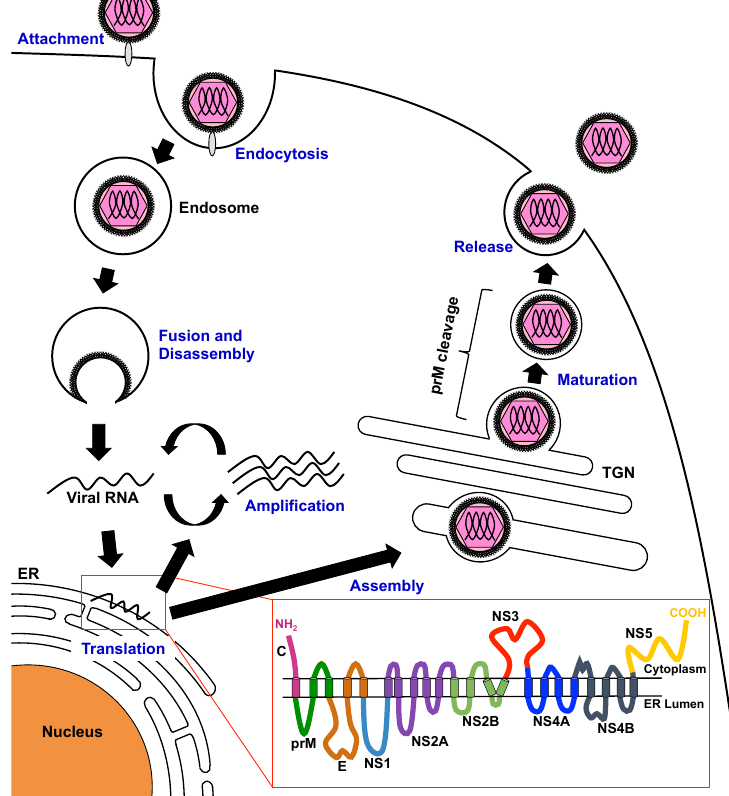
Figure 1. Schematic model of the dengue virus (DENV) life cycle. DENV particles bind to host cell factors and then enter the cell by clathrin-mediated endocytosis. After trafficking to endosomal compartments, envelope protein-mediated fusion of viral and cellular membranes occurs with changes in pH, allowing disassembly of the virus particles and release of single-stranded viral RNA into the cytoplasm, where translation occurs. The viral RNA is then translated to a polyprotein, which is processed by host cellular and viral proteases. Nonstructural (NS) proteins then replicate the viral RNA. Viral particle assembly occurs on the membrane of the endoplasmic reticulum (ER), and particles then bud into the ER as immature virus particles. During egress of the progeny virus particle through the secretory pathway, pre-membrane (prM) protein is cleaved by the cellular serine protease furin. Mature virus particles are released into the extracellular space. The red inset indicates the putative membrane topology of the viral proteins. TGN: trans-Golgi